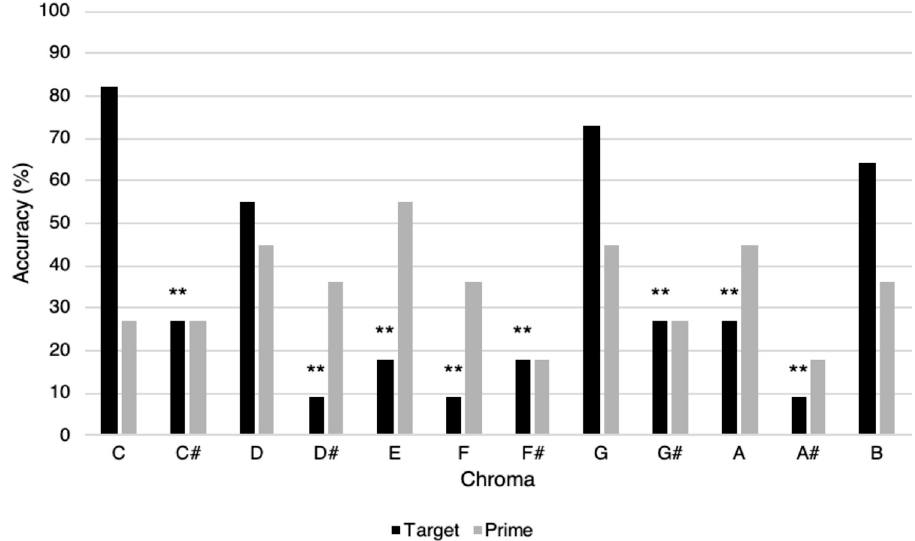
Fig 7. Accuracy profile for a QAP participant (participant 32) with significant target chroma, AP-P task accuracy 34.85%. Marked target chroma were significantly less likely to be accurately identified than the statistical reference point of C, according to this participant’s logistic regression model. As the majority of “poor” target chroma corresponded to the black keys of the piano, this participant may be considered to have “white-note” AP (relatively good performance for white-key chroma). As prime chroma did not significantly predict the likelihood of a correct response, it is unlikely that this participant employed a reference chroma strategy for identifying pitches ( �� p < .01).